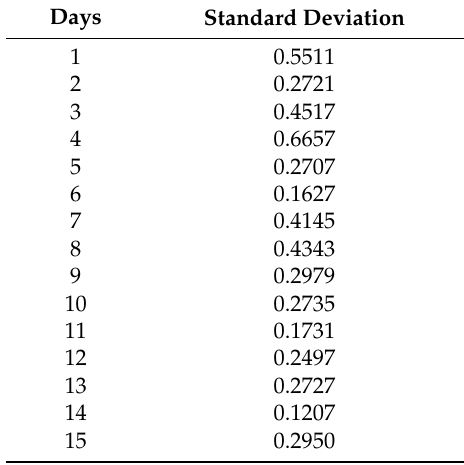
Table 8. Deliverer’s cumulative delivery time standard